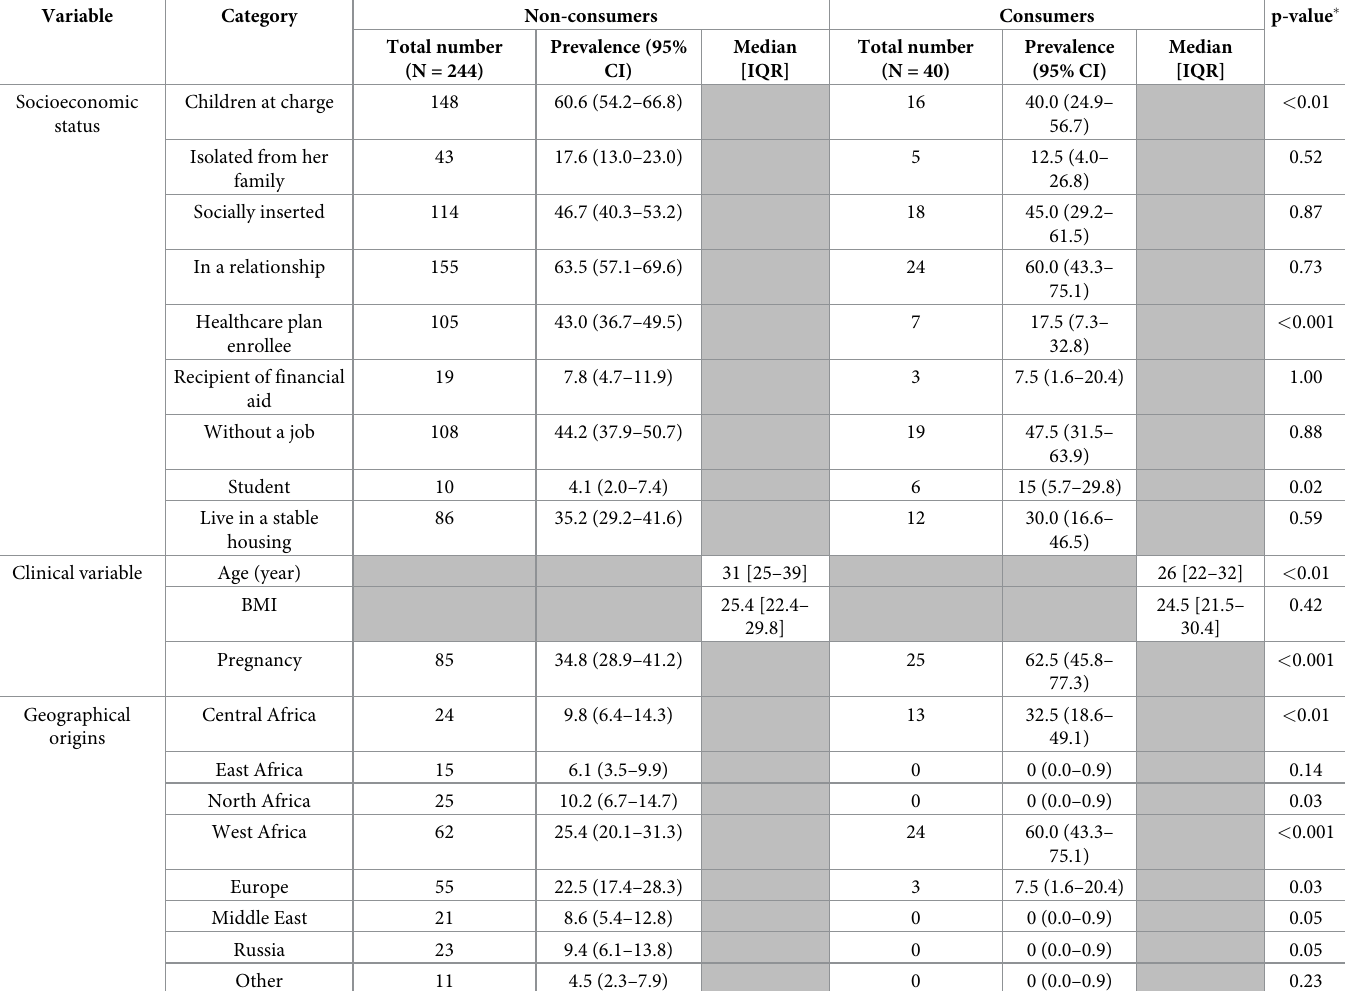
Table 3. Characteristics of the study population according to kaolin